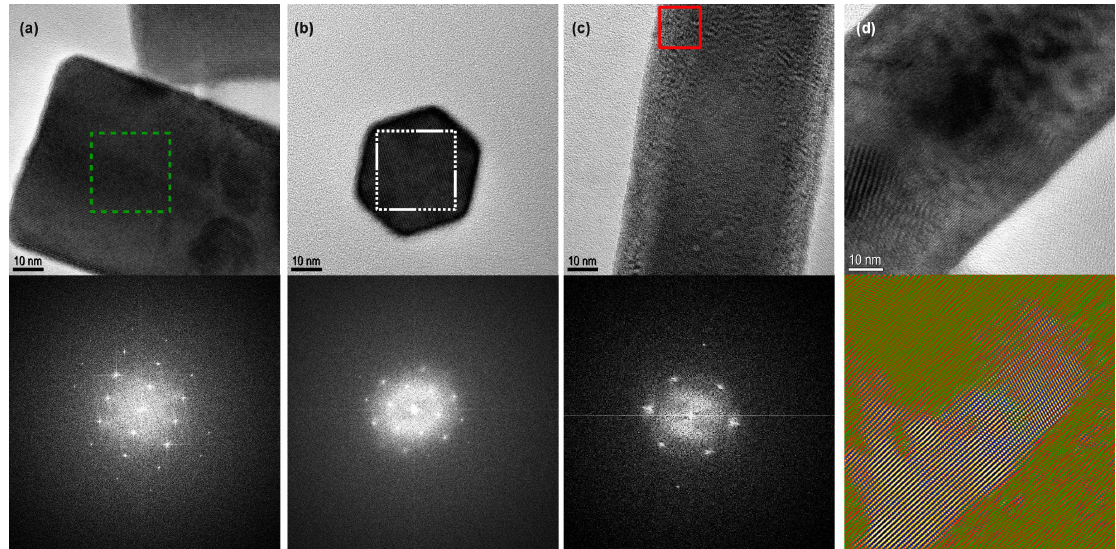
Figure 7. ( a – c ) HRTEM of NPs with below the FFT of the indicate area ( a ) NR09 with a typical FFT orthogonal to the c-axis ( b ) NR13 with a typical FFT parallel to the c-axis ( c ) NR11 with a FFT characteristic from an hexagonal phase trough the c-axis but observed orthogonally to the c-axis. ( d ) HRTEM of a NR06 with various defects below same image filtered with false